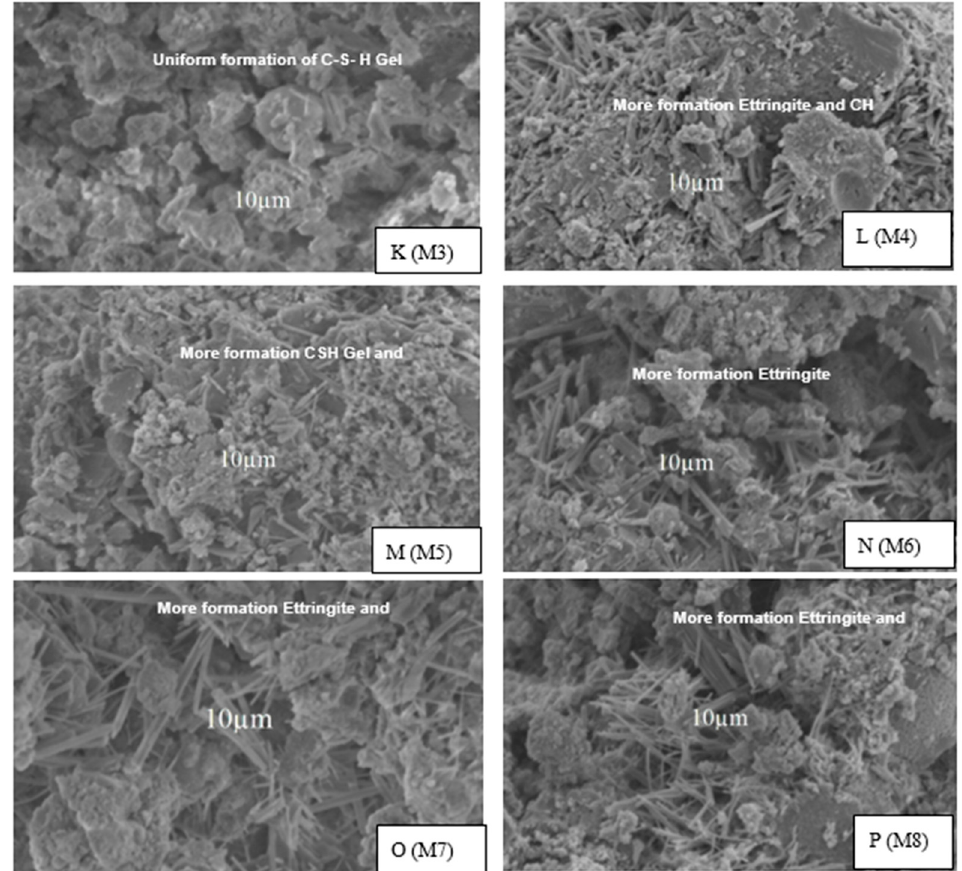
Figure 10. ( A – H ) SEM images of test block samples of different mixes containing different dosages of SAP and nano-silica without superplasticiser; ( I – P ) SEM images of test block samples of different mixes containing different dosages of SAP and nano-silica with a constant dosage of superplasti- ciser (0.5%).